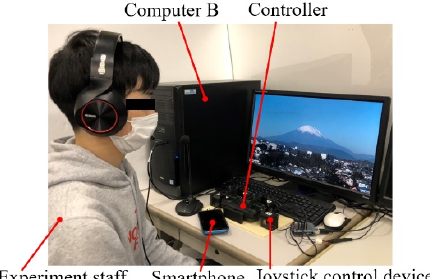
Figure 6. Experiment staff (Tokai University).